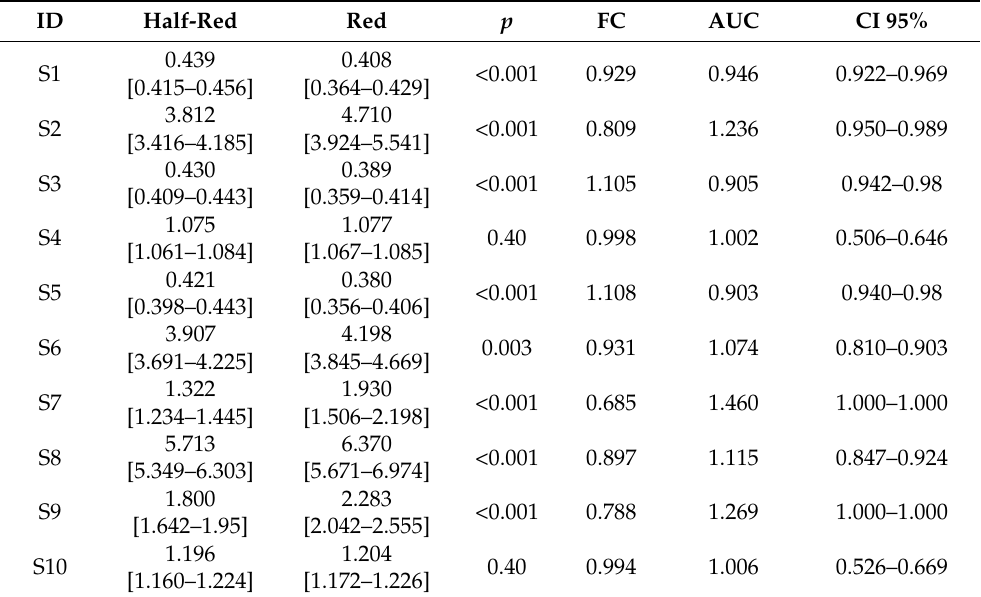
Table 1. Univariate data analysis: ID indicates the sensor name, in columns half-red and red the median (5th–95th) percentile is reported for the two maturity stages, p is the p -value of the factor maturity stage obtained by LME, FC is the fold change calculated as the ratio between the median of red and the median of half-red, AUC is the area under the ROC curve and CI 95% is the confidence interval of AUC at the level of